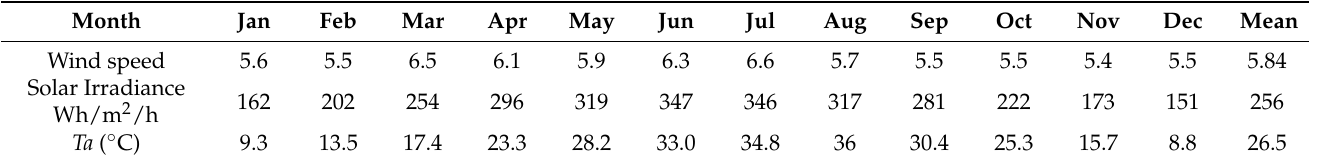
Table 2. The wind speeds collected at 40 m above sea level, solar irradiance on a horizontal surface, and temperature for the Dumah AlJandal